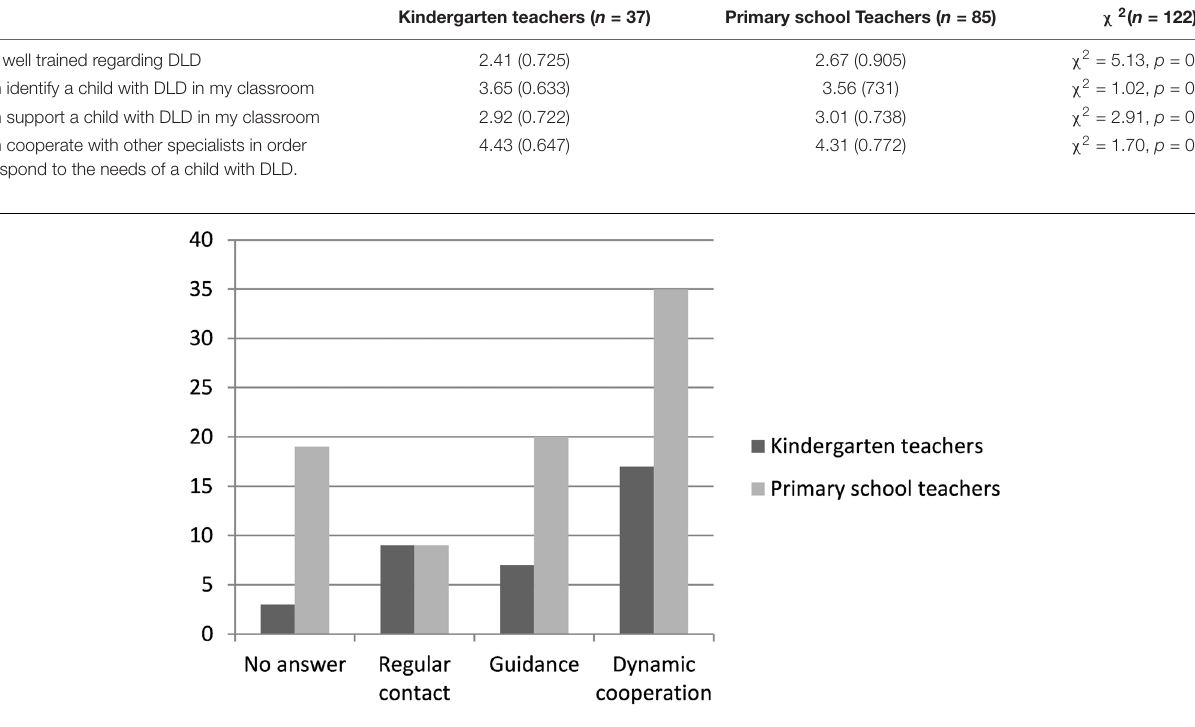
FIGURE 1 | Proposed ways of cooperation by the